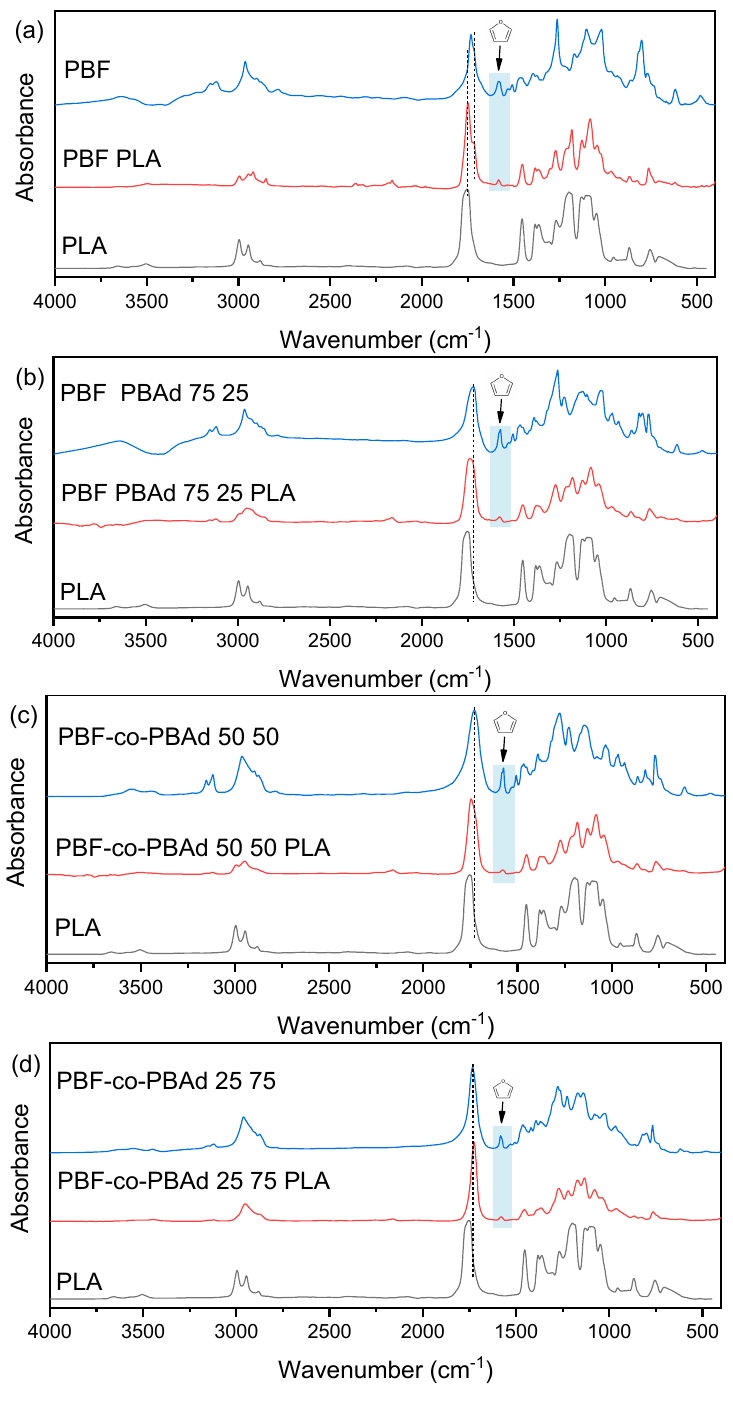
Figure 3. FTIR spectra of ( a ) PLA, PBF and PBF PLA blend ( b ) PLA, PBF-PBAd 75 25 and PBF-PBAd 75 25 PLA blend, ( c ) PLA, PBF-PBAd 50 50 and PBF-PBAd 50 50 PLA blend and ( d ) PLA, PBF-PBAd 25 75 and PBF-PBAd 25 75 PLA blend.